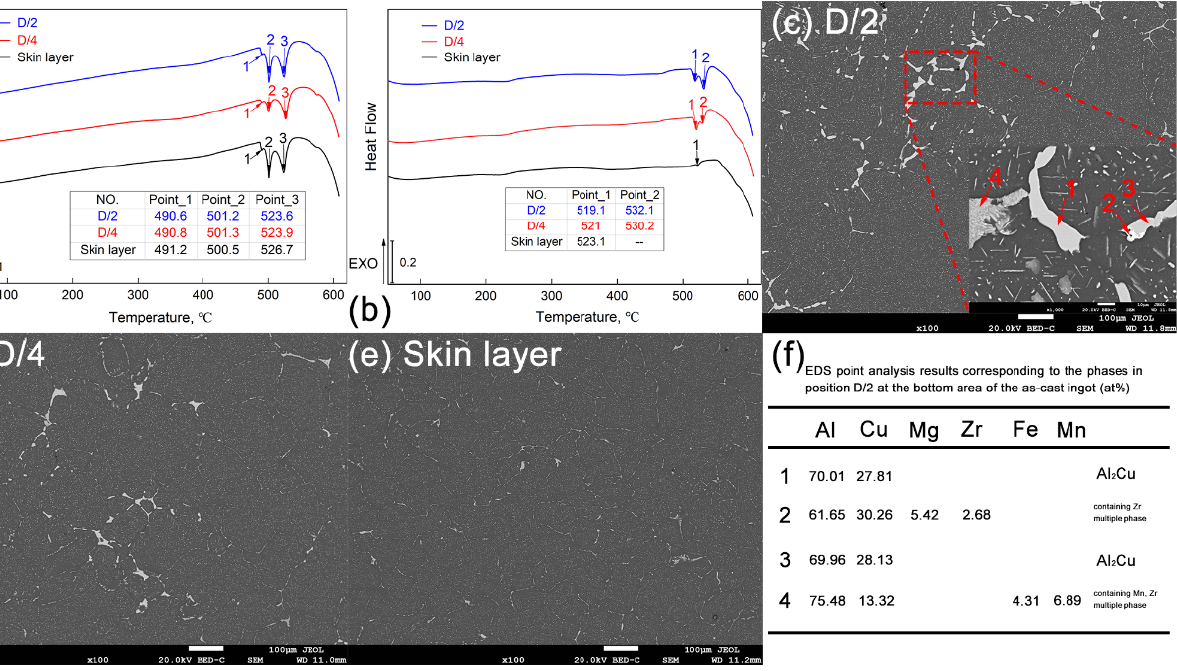
Table 2. Various homogenization heat treatment principles.